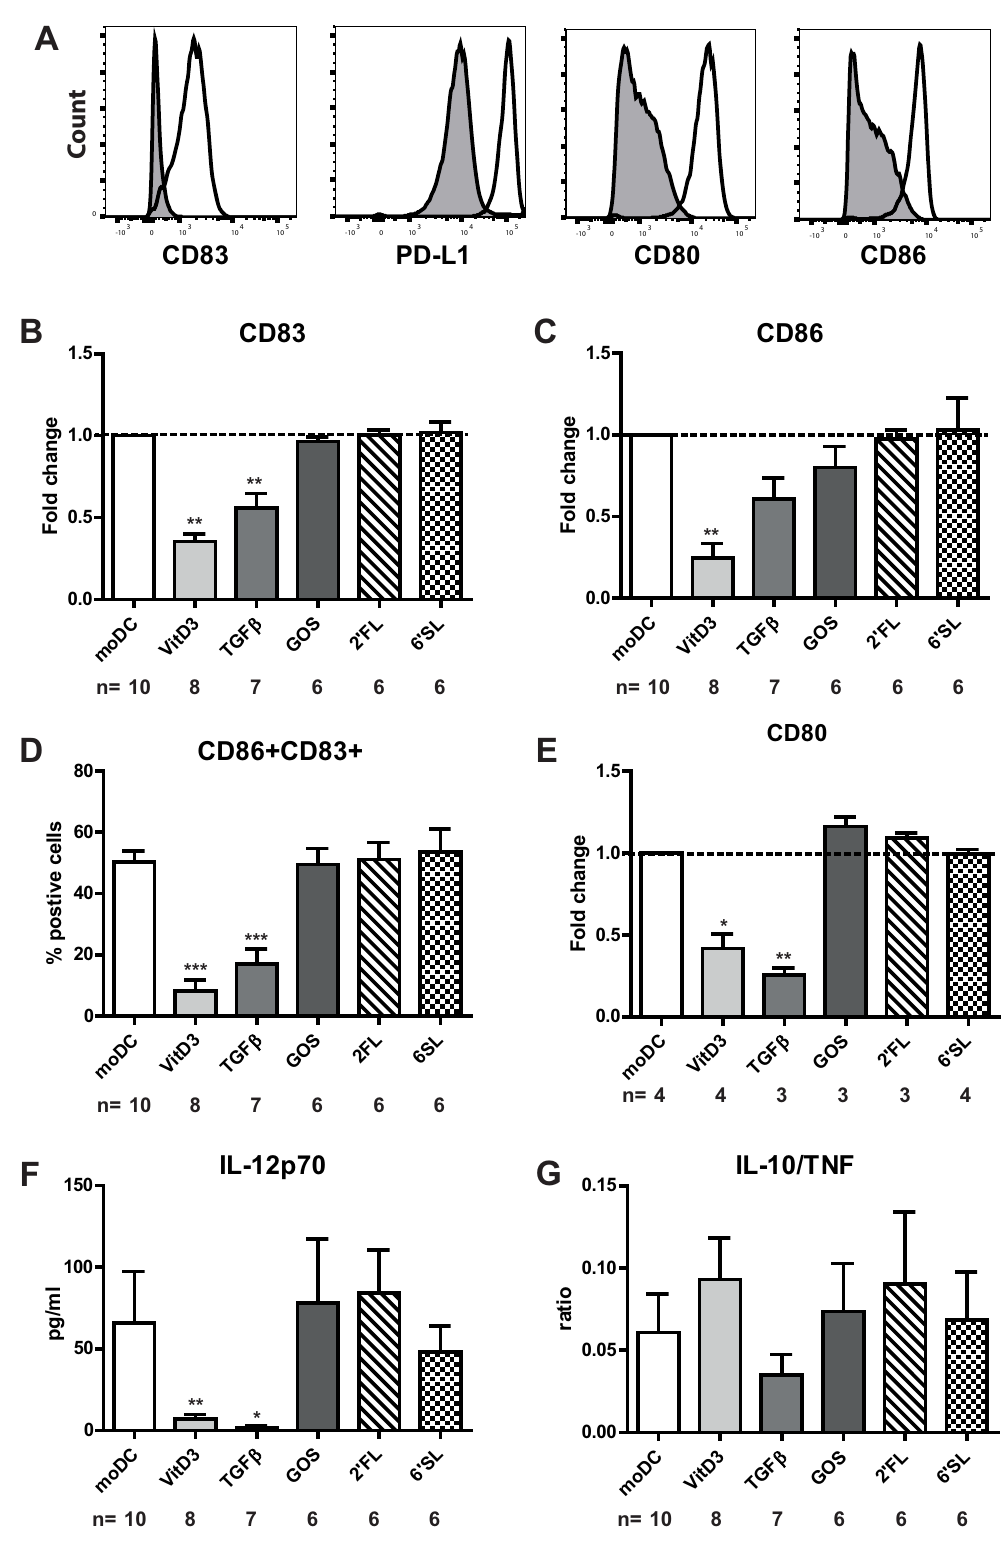
Fig 3. TGF β DCand VitD3DC induce tolerogenic DC. Immature DC were stimulated with LPS for 48 hours. A) The expression of CD83, PD-L1, CD80 and CD86 on immature DC (shaded histograms) or mature DC (open histograms)